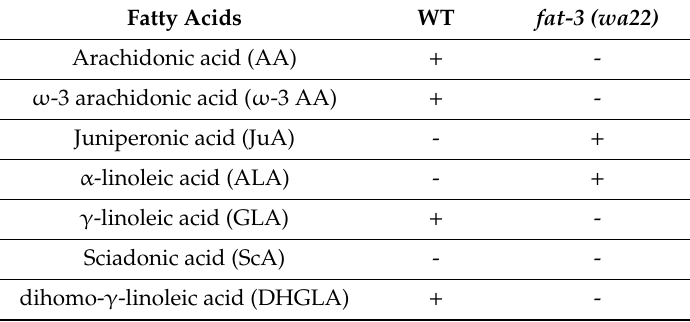
Table1. Detectionoffattyacids(FAs)relevanttothisstudyinwildtypeN2(WT)and fat-3(wa22) animals. Fatty Acids